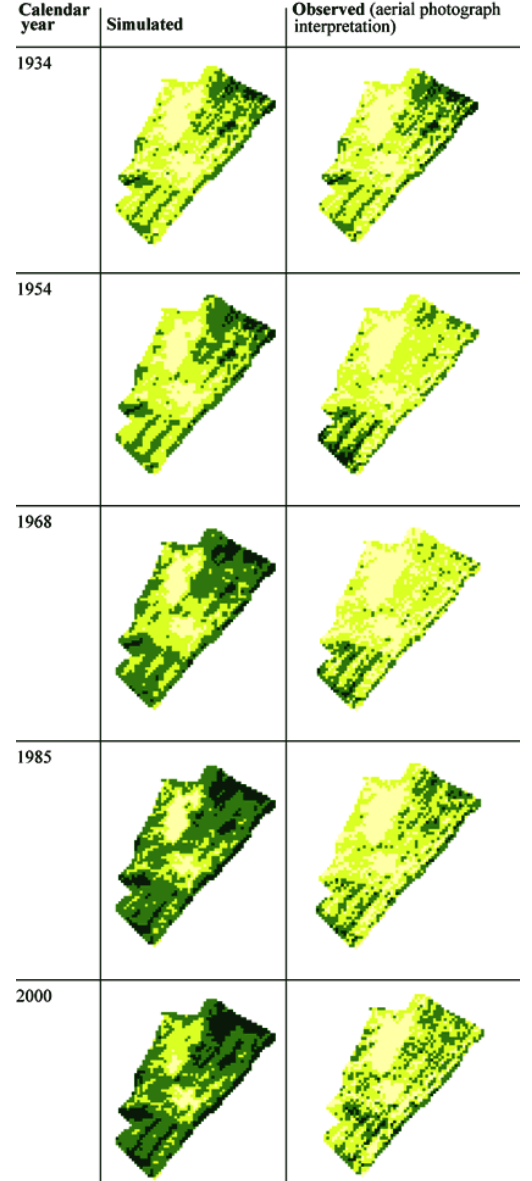
Fig. 6 . Short-term historical simulations (1934 AD–2000 AD) and observed (2000 AD) landscape mosaics in the pasture Rionde during the twentieth century. The simulation outcome for year 2000 differs from the simulation outcome of the long-term historical simulations (Fig. 4) because we started the short-term simulation from a detailed interpretation of aerial photographs (Chételat et al. 2012). The fine-scale patterns persisted during the simulation of the twentieth century but were not simulated with the same precision since the Middle Ages. The four phytocoenosis types used for display are defined in Table 3; a legend is provided with Fig.